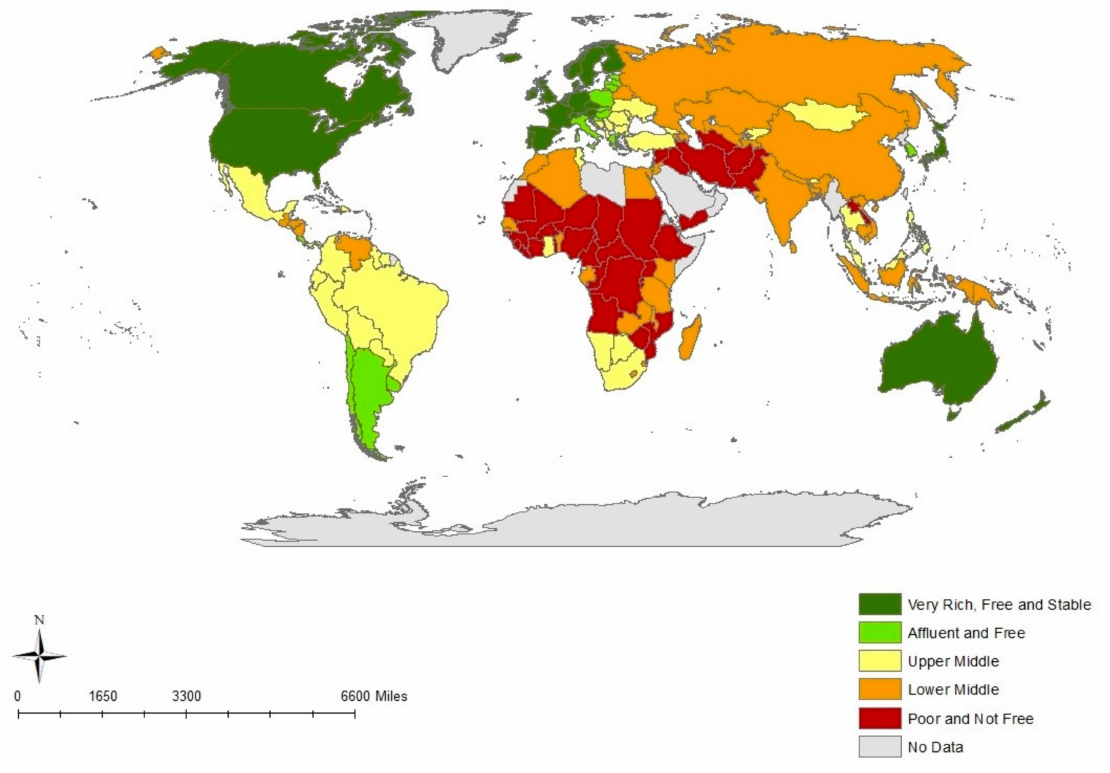
Figure 2. A five-group